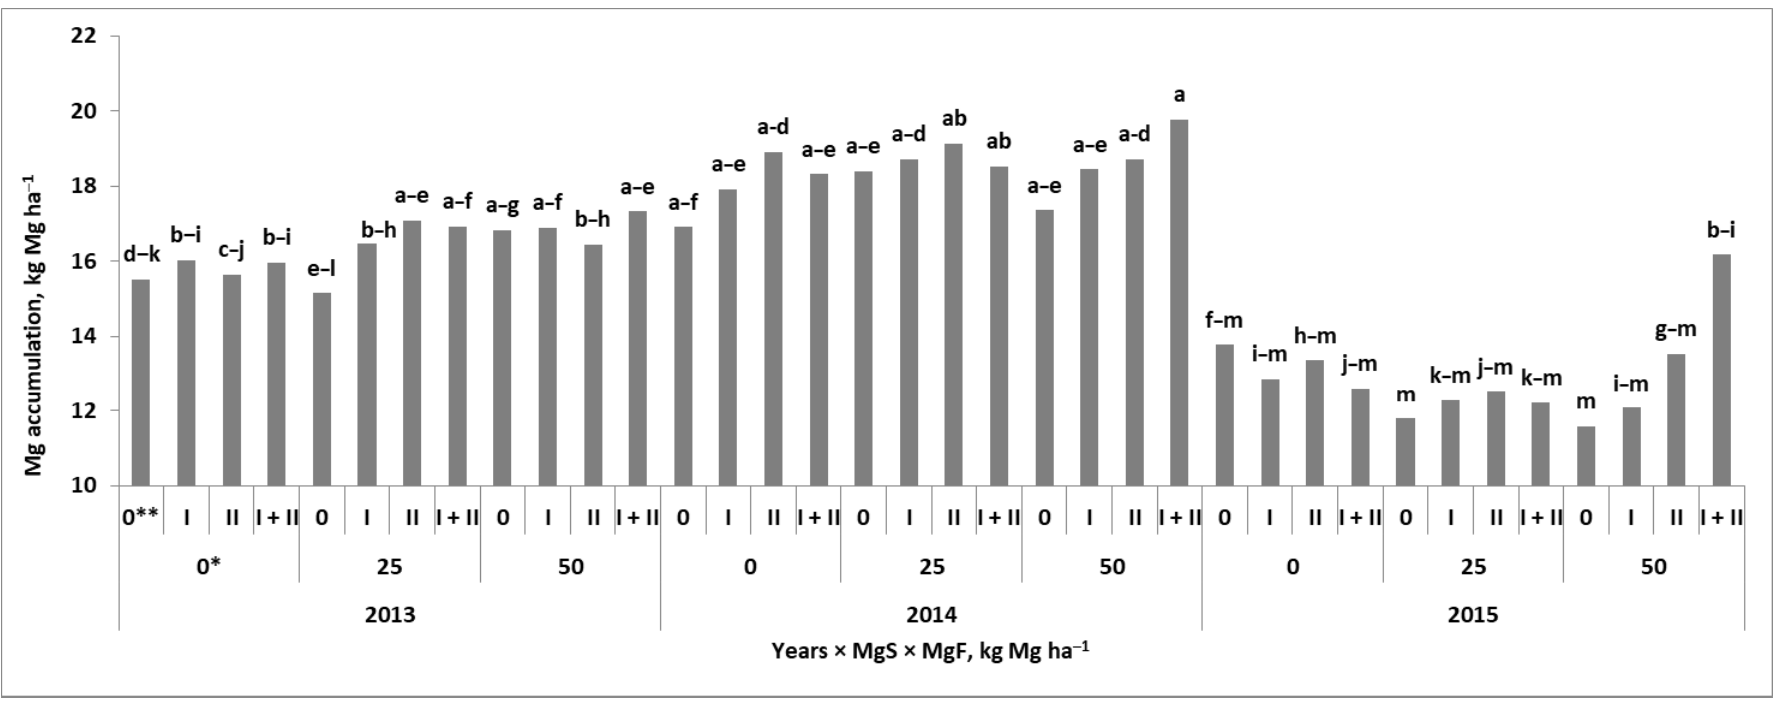
Figure 2. Magnesium accumulation by winter wheat in response to Mg fertilization systems and years. a, b, c, d, e, f, g, h, i, j, k, l, m Similar letters mean a lack of significance; differences using Tukey’s test. Mgs and Mgf — soil and foliar Mg fertilization systems, respectively. * Doses of applied Mg, kg ha ‒1 ; ** stages of Mg foliar fertilization to wheat: I — BBCH 30; II — BBCH 49/50.